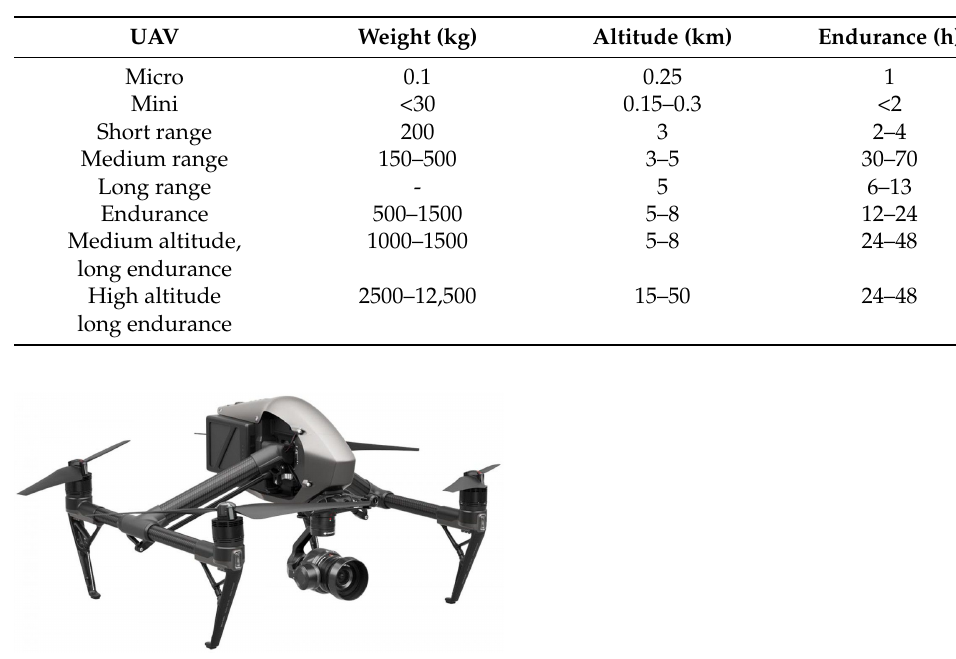
Figure 1. DJI Inspire 2, a mini UAV weighing around 3.3 kg and capable of a flight time up to 27 min